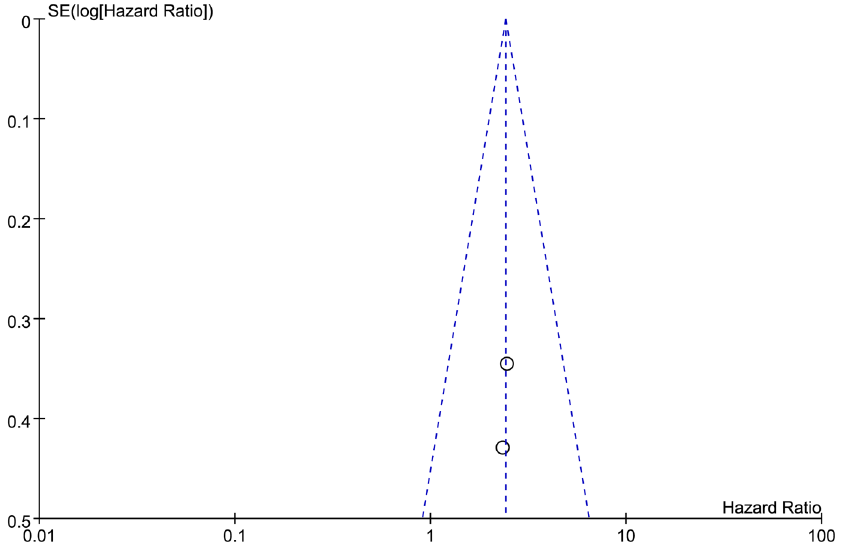
Fig 5. Funnel plot was used to visualize a potential publication bias on disease free survival